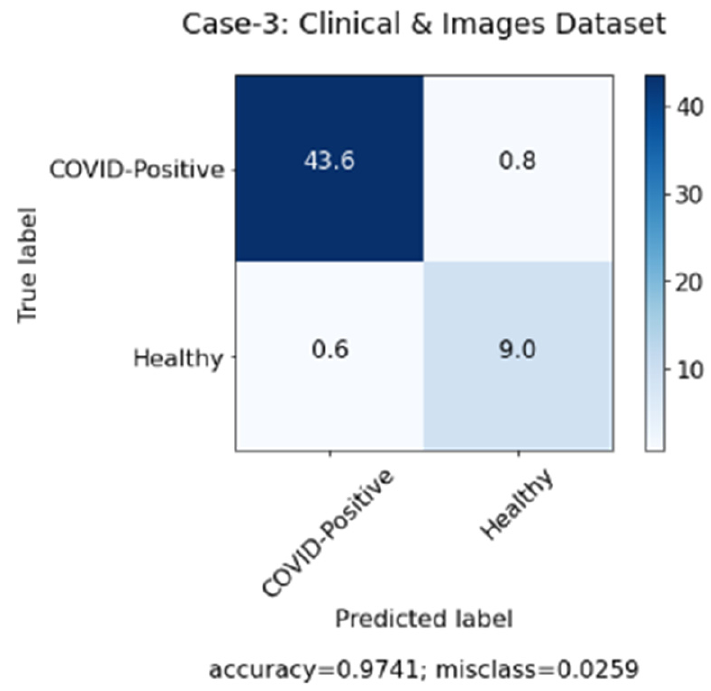
Figure 8. Confusion matrix for case 3 (clinical data and chest X-ray (CXR)).